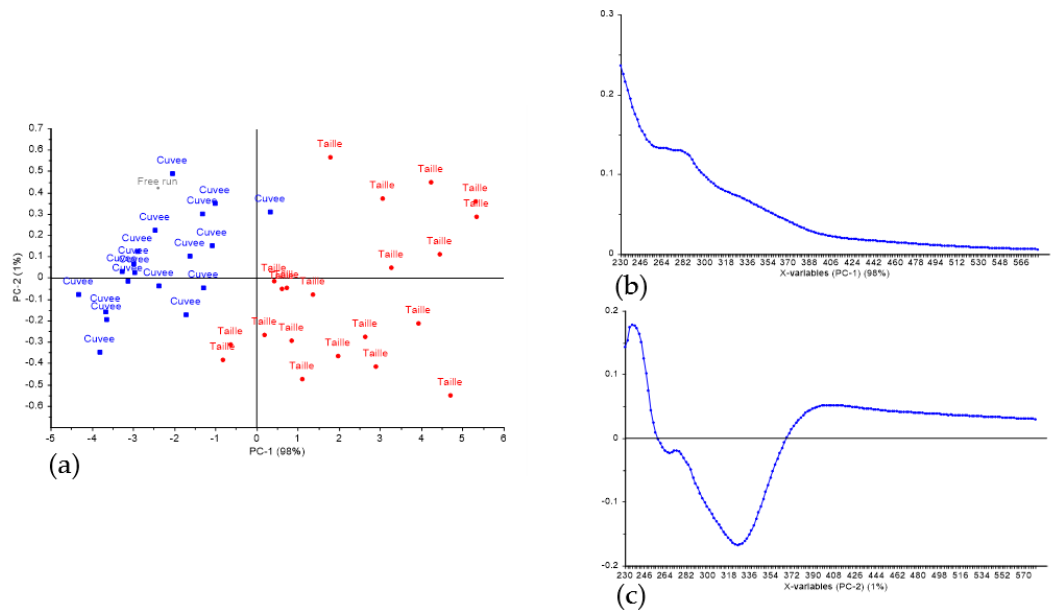
Figure 4. PCA scores and loadings plots of 2012 Chardonnay juice samples from the commercial scale trial discriminating cuv é e from taille . Scores plots ( a ); PC 1 ( b ) and PC 2 ( c ) loadings.